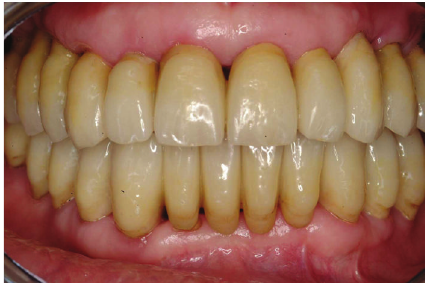
Figure 34: The final impression was performed using a single-phase technique with double components polyether and individual tray.